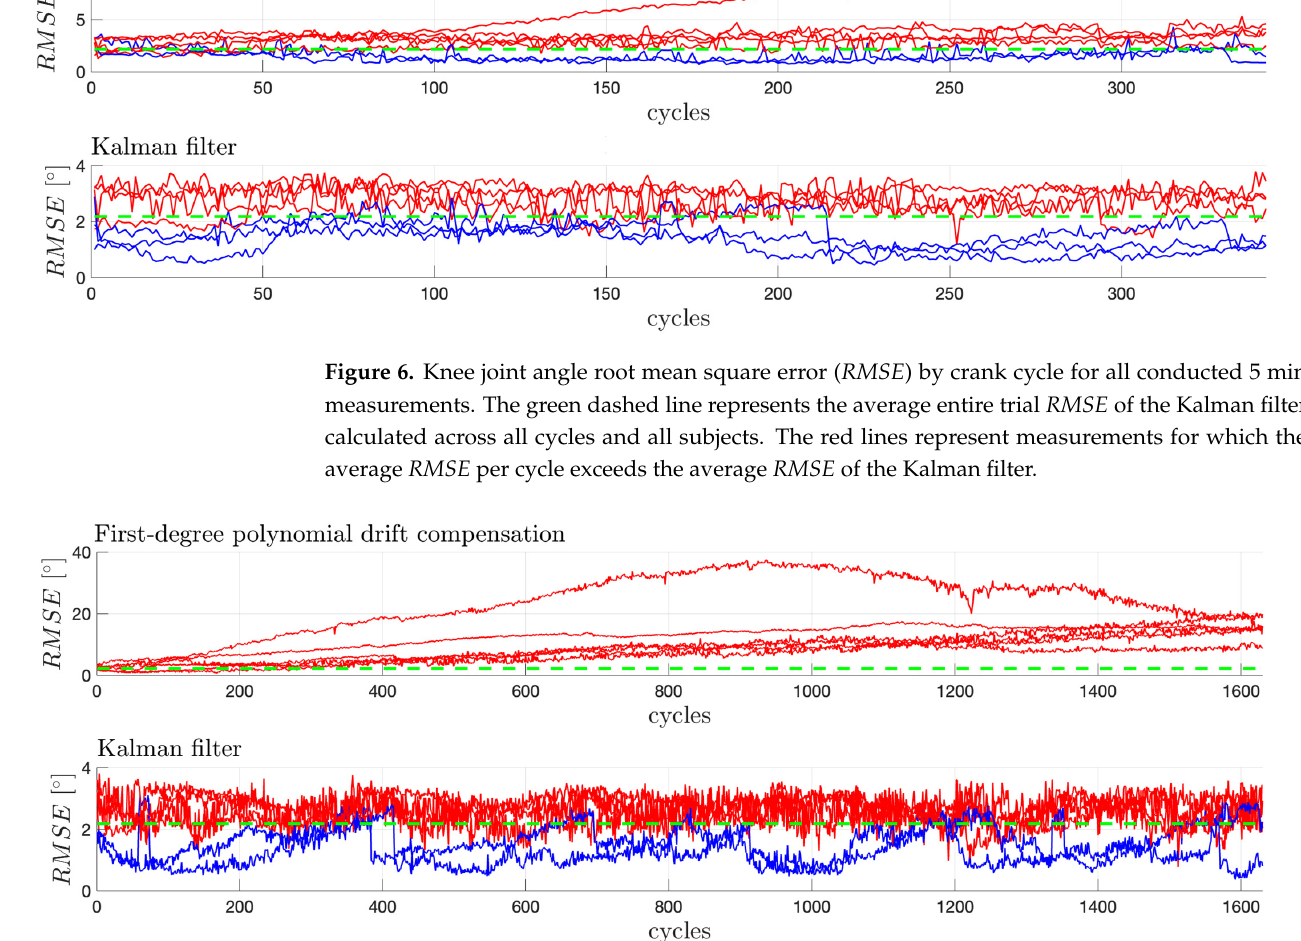
Figure 8. Knee joint angles obtained using the proposed IMU-based method and reference optical motion tracking system, respectively plotted with respect to the computed crank angle. The gradient from dark blue to bright yellow is used to differentiate subsequent cycles, from the first to the last. 5. Discussion From the RMSE values presented in Table 2, we can observe that the Kalman filter clearly provides for better knee joint angle results, with the average RMSE values per cycle being in-between 1.39 and 3.12° for all 5 min measurement trials. For comparison, the